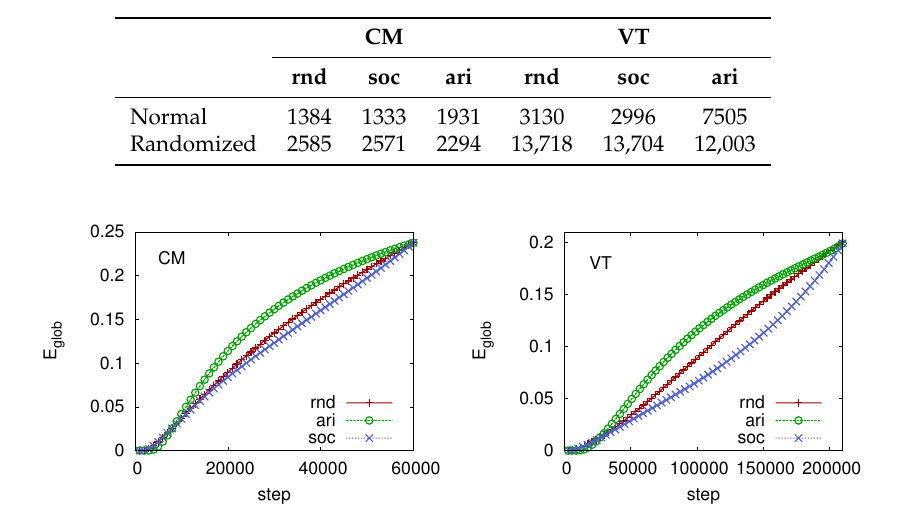
Table 4. Summary of T min , i.e., the minimum number of simulated steps to get the original E glob , for all accelerated simulations in Communities (CM), VirtualTourist (VT), and randomized version of both networks. Random (rnd), aristocratic (ari), and social (soc) rules are considered.